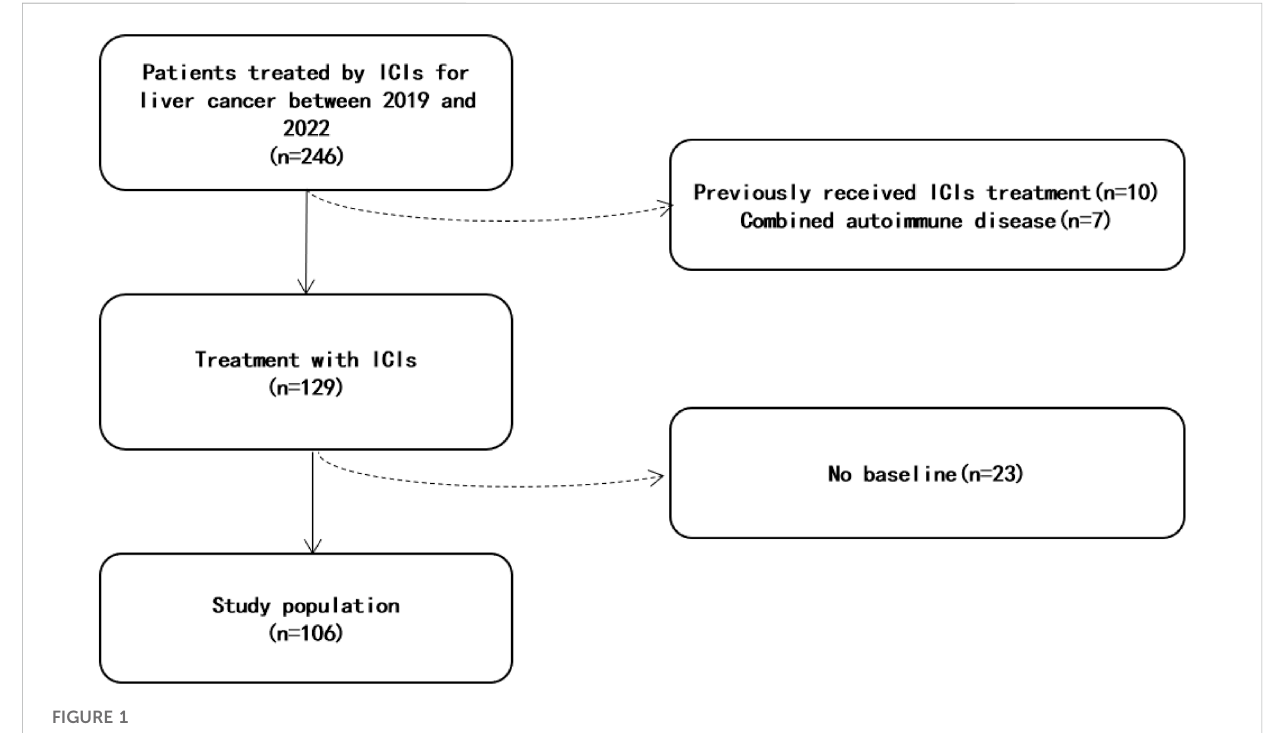
levels, ACTH hormone levels, liver function, renal function,